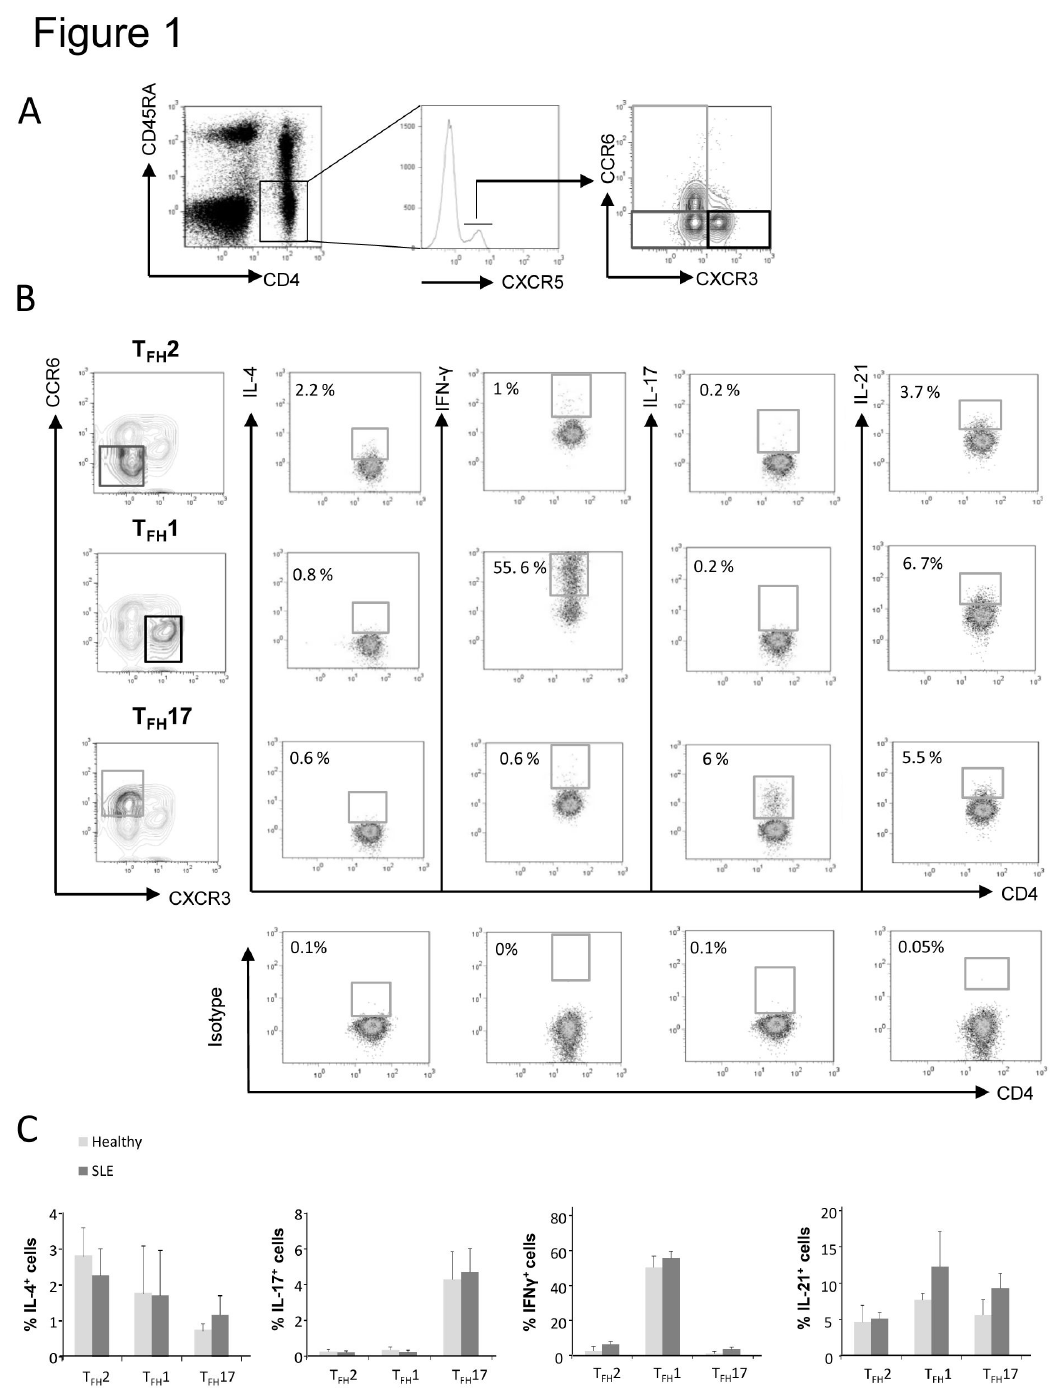
Figure 1. Cytokine production by T cell subsets. Purified CD4 + T cells from healthy controls were cultured for 5h with PMA, FH ionomycin and monensin. CD4 + T cells were then stained with fluorescently-labeled Abs specific for CD4, CD45RA, CXCR5, CCR6 and CXCR3. (A) T subset distribution was determined thanks to CXCR3 and CCR6 expression on gated CD4 + CD45RA - CXCR5 + T FH cells allowing the identification of T 17 cells (CXCR3 - CCR6 + , light grey), T 2 cells (CXCR3 - CCR6 - , dark grey) and T 1 cells FH FH FH (CXCR3 + CCR6 - , thick black). Frequencies of IL-4, IFN-γ, IL-17 and IL-21 positive cells were determined by intracellular staining on each T subset after setting the threshold using isotype control staining. Dot plots (B) from one healthy control is shown as example FH and histograms (C) from 3 healthy controls and 3 SLE patients are shown. Data are expressed as % ± sem. doi: 10.1371/journal.pone.0075319.g001 PLOS ONE |